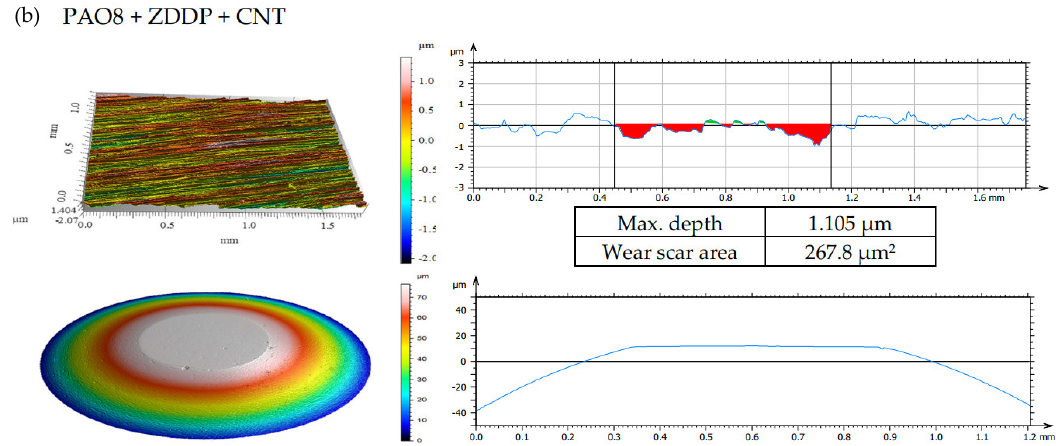
Figure 9. Isometric views and primary profiles of the discs and balls after the tribological tests of PAO8 + ZDDP + CNT on TRB 3 tribotester equipped with ( a ) disc coated by a-C:H and ( b ) uncoated. Table 5 provides the surface texture parameters recorded for the discs and balls before and after the tribological tests. The results obtained for the uncoated steel discs are given in Table 5a, while the data concerning the a-C:H coated discs are shown in Table 5b. Table 5. Surface texture parameters for the uncoated steel discs and steel balls before and after the tribological tests.